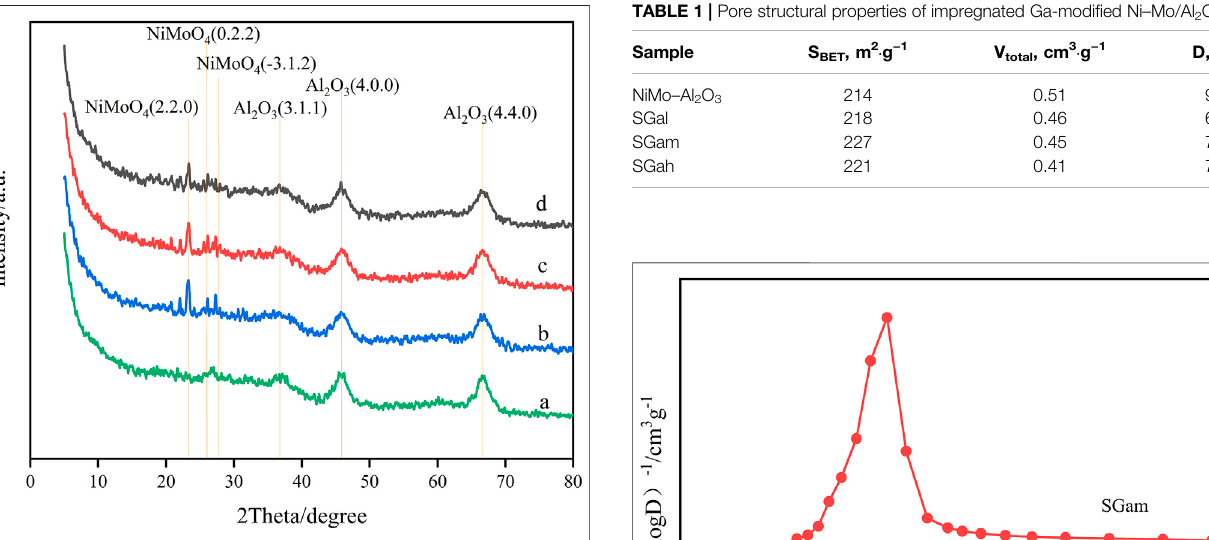
FIGURE 1 | XRD patterns of impregnated Ga-modi fi ed Ni – Mo/Al 2 O 3 : (a) Ni – Mo/Al 2 O 3 , (b) SGal, (c) SGam, and (d) SGah.